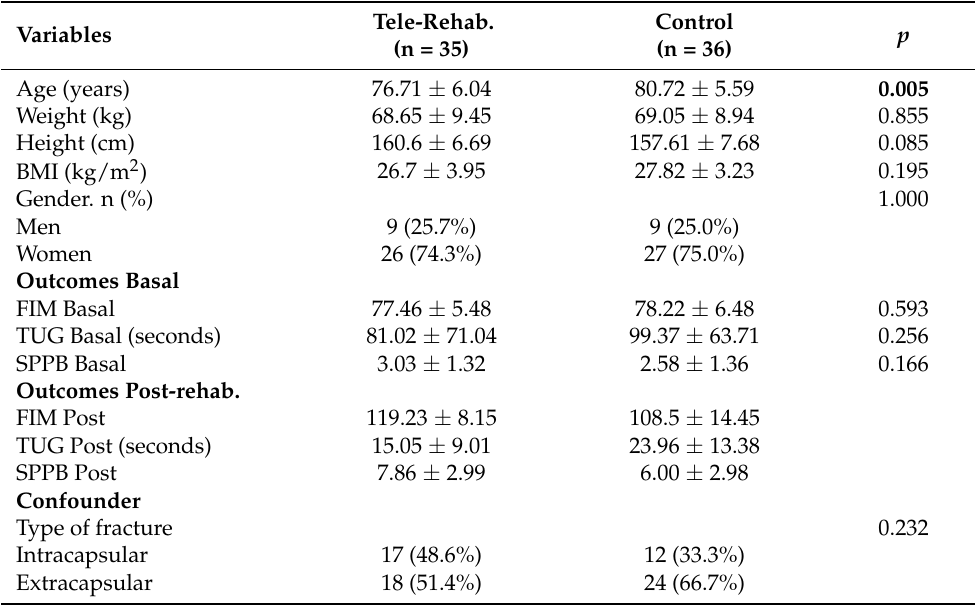
Table A1. Baseline characteristics of sample divided by tele-rehabilitation (tele-rehab.) and control group. Variables